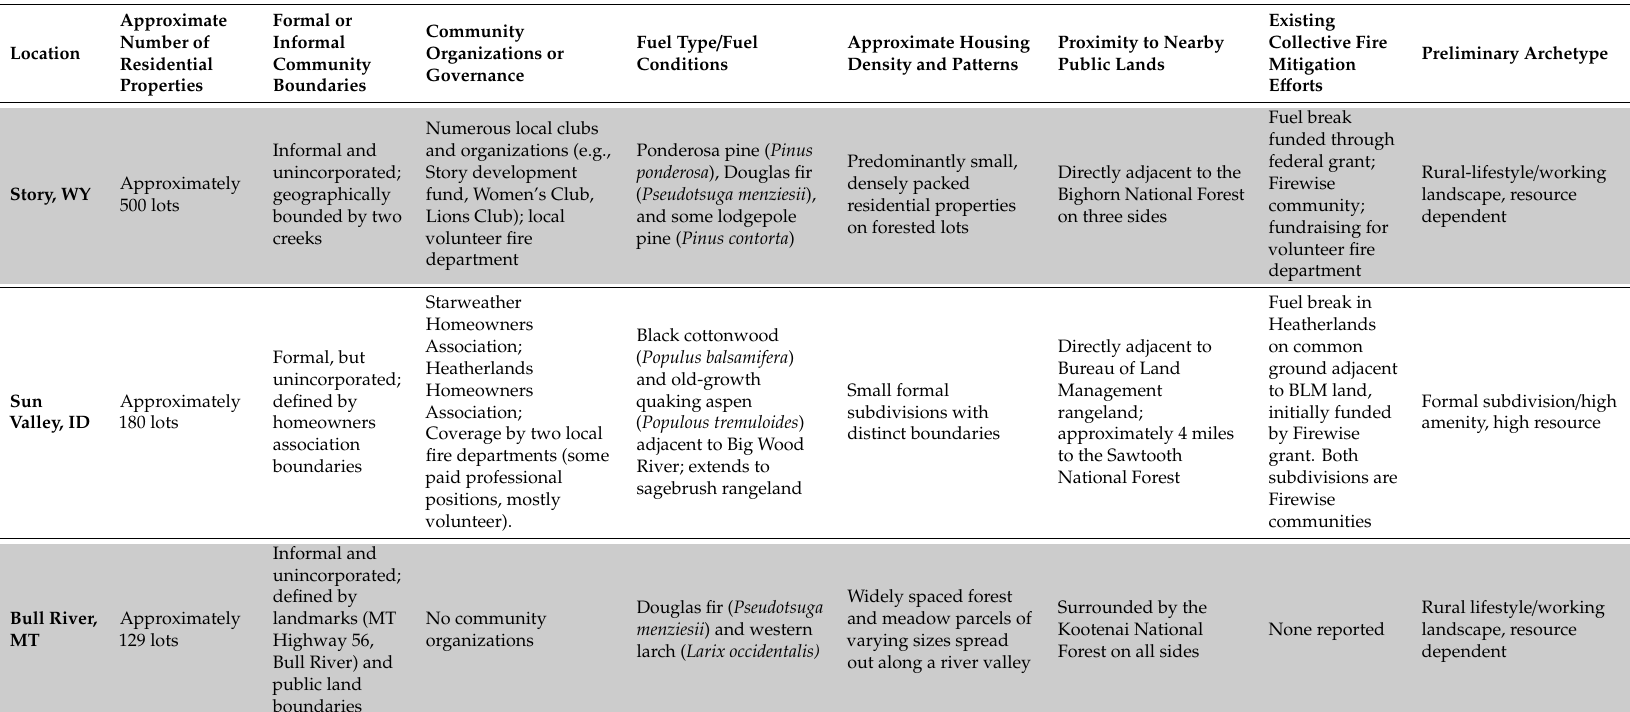
Table 1. Select characteristics of case study locations selected for